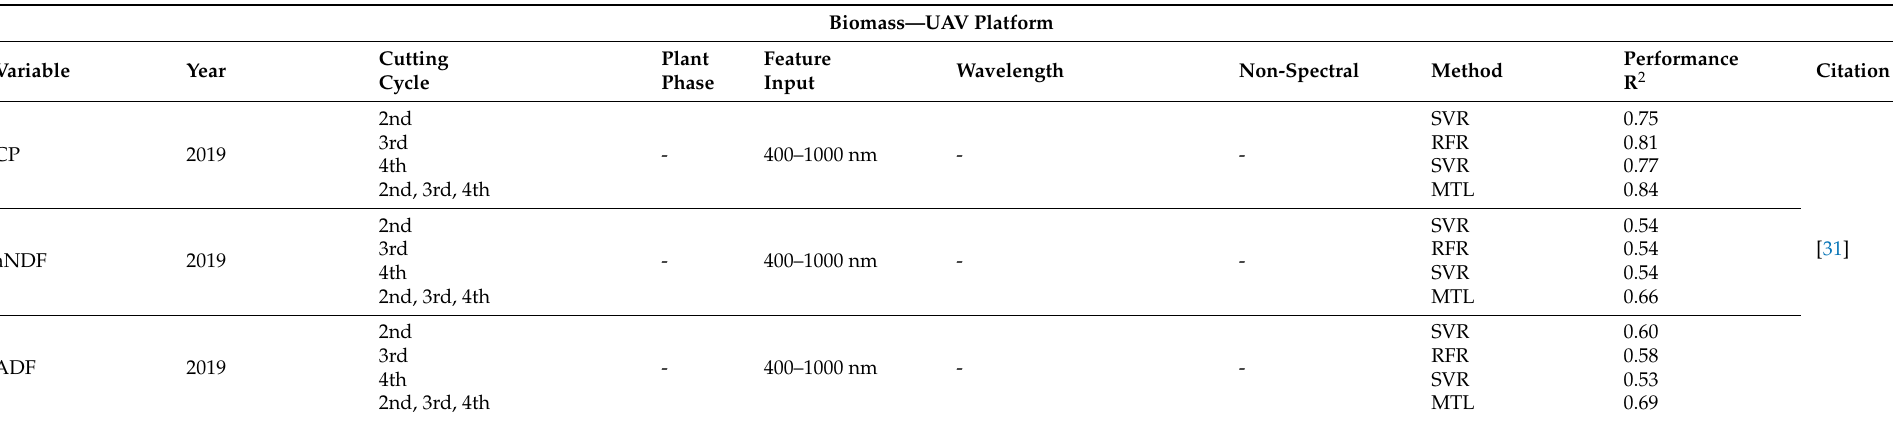
Table A5. Most accurate features for predicting alfalfa quality traits using UAV